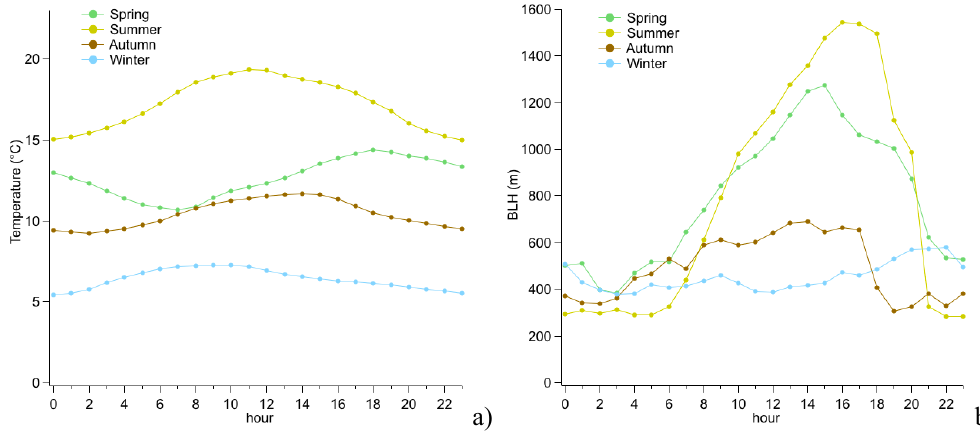
Figure 9. Average diurnal variations by seasons of temperature (a) and BLH (b)